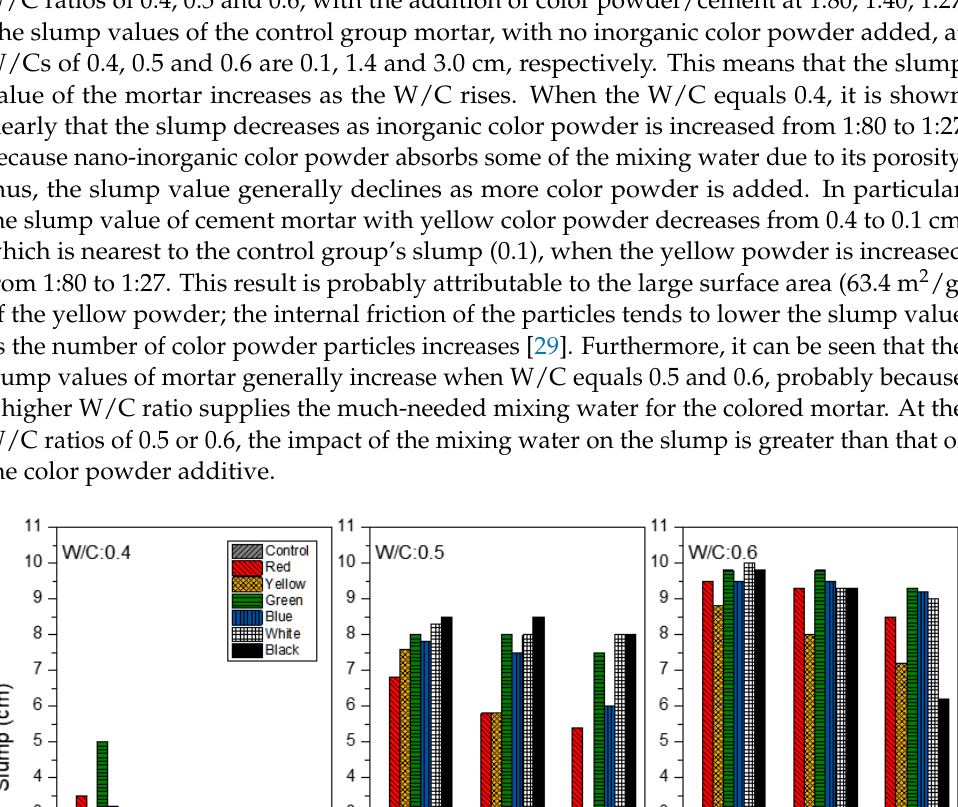
Figure 4. Slump flow of colored mortar at W/C = 0.4, 0.5 and 0.6 when weight ratios of color pow- der/cement at 1:80, 1:40, and 1:27 are added. 3.2. Hardened Properties Figure 5 shows the compressive strength analysis of the mortar obtained from the weight ratios of color powder/cement at 1:80, 1:40 and 1:27, respectively, at the W/C ratio of 0.4, and under saturated limewater curing. The compressive strength of the mortar increases with age. The compressive strength values of the control group mortar are 49.07, 65.19 and 71.30 MPa at day 3, day 28 and day 120, respectively, representing about a 24.73% increase